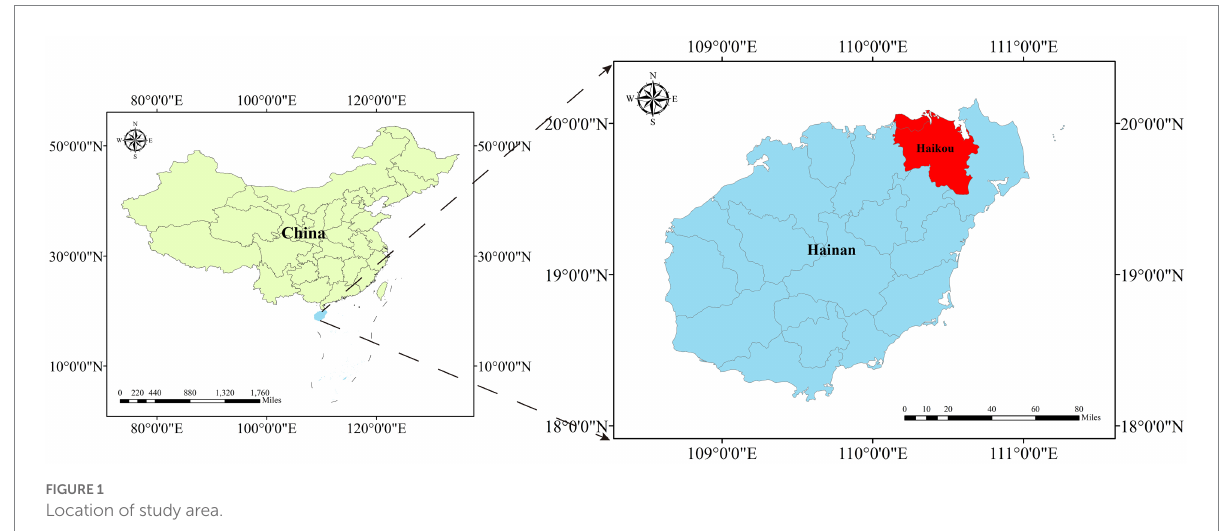
FIGURE 1 Location of study